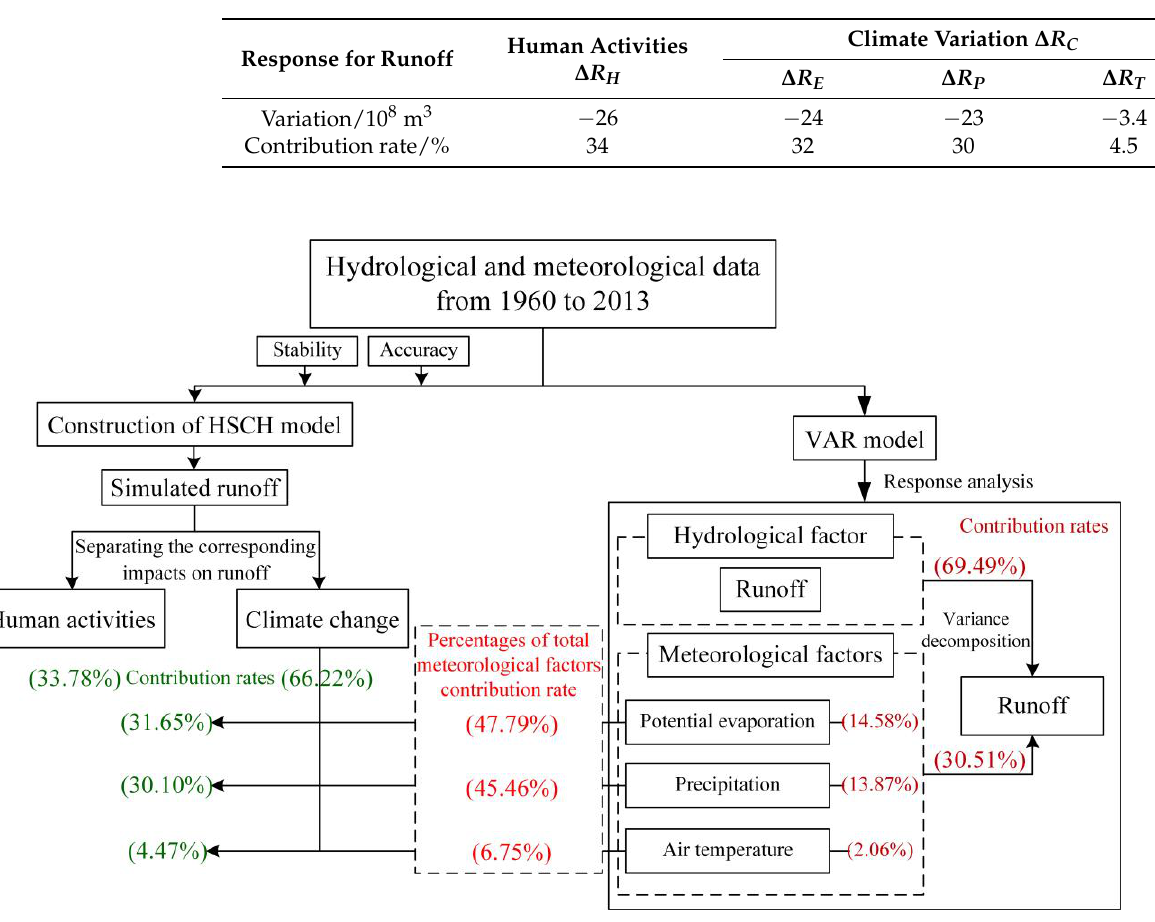
Figure 11. Process graph for the dynamic response of the four groups of hydro-meteorological factors (Q, P, E and T represent runoff, precipitation, potential evaporation and air temperature, respectively). Table 8. Contribution rates of meteorological factors to runoff.